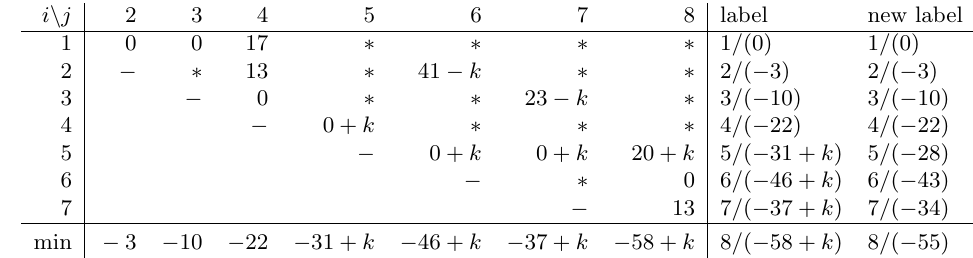
Table 5: Modified activity weights after the crash considerations of activity (4 , 5)